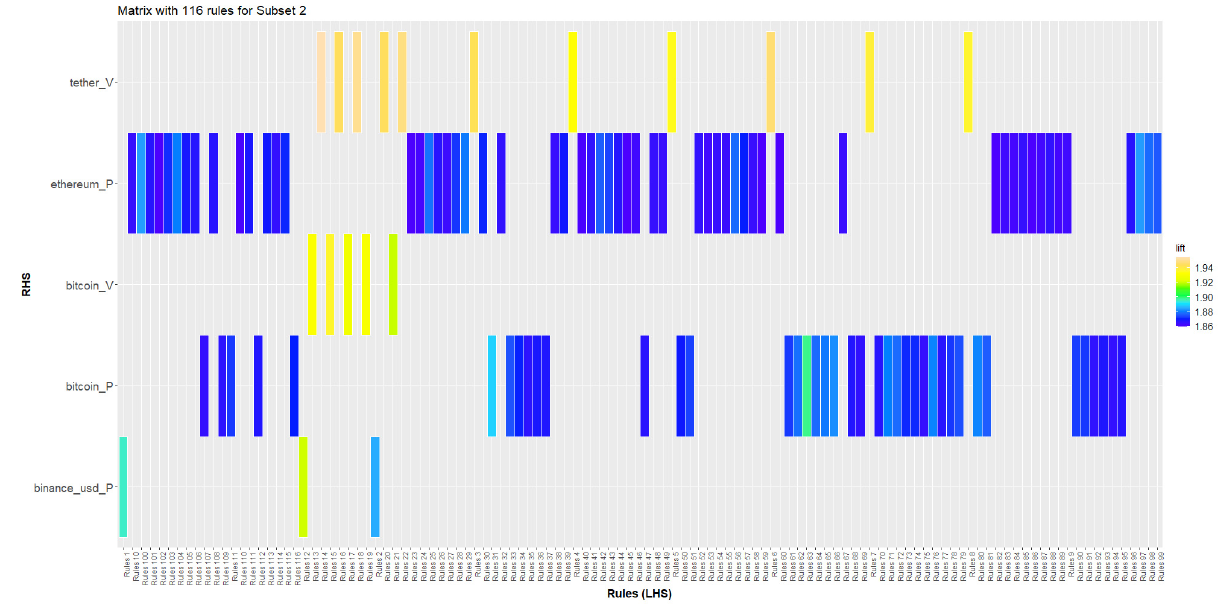
Figure 6. Matrix-based plot for Subset